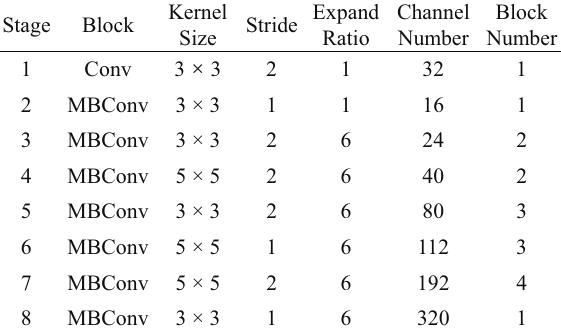
Table 1. The details of baseline backbone network Efficient-B0. layer to expand the channel dimension before the depth-wise convolution. In addition, squeeze-and-excitation is introduced into MBConv, and it is placed after the depth-wise convolution to build the dependencies between different channels. Further- more, the shortcuts between the bottlenecks are used to improve the gradient propagation between layers. The structure of MB- Conv is shown in Figure 1, where Conv means convolutional layer, BatchNorm is the batch normalization (Ioffe, Szegedy, 2015), Swish is a kind of activate function (Ramachandran et al., 2017), and FC denotes the fully connection layer. The de- tails of the baseline network Efficient-B0 are listed in Table 1.